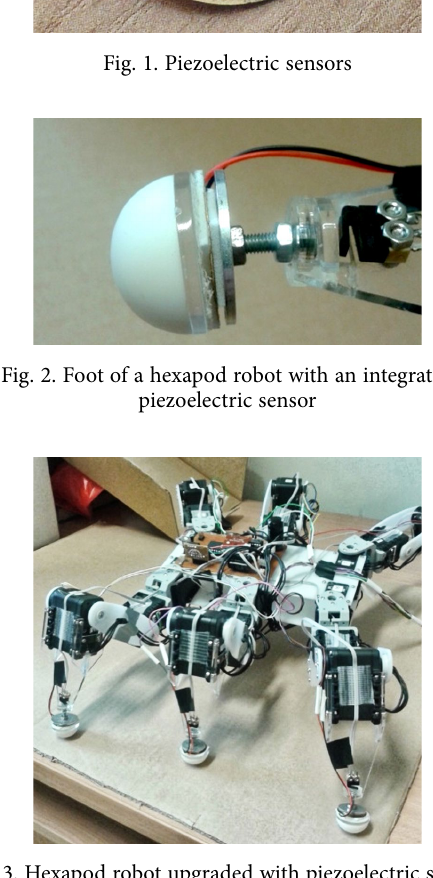
Fig. 3. Hexapod robot upgraded with piezoelectric sensors